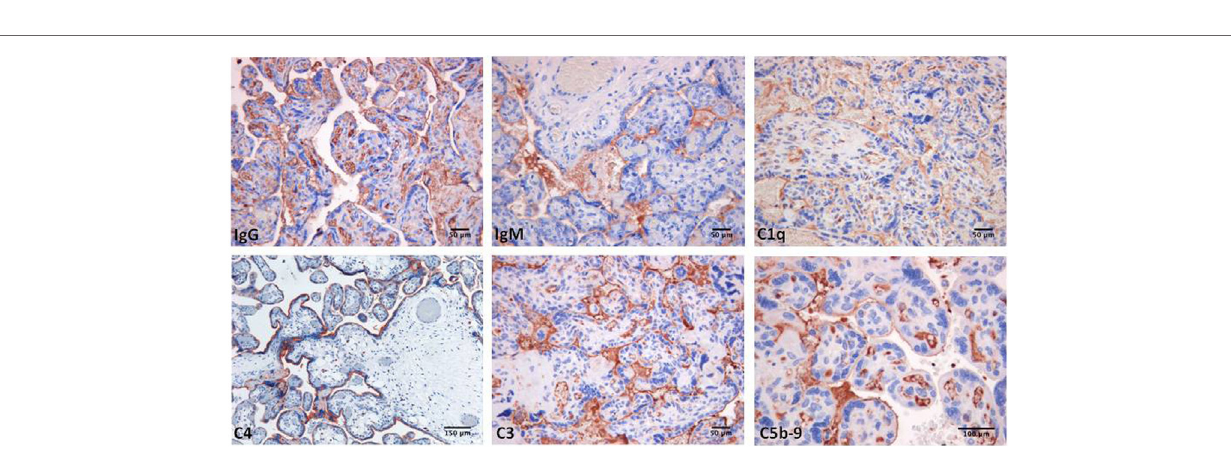
FiGUre 2 | Immunoperoxidase staining of representative placental villi from a primary antiphospholipid syndrome patient showing deposition of immunoglobulin (Ig) and various C components (20 × magnification).